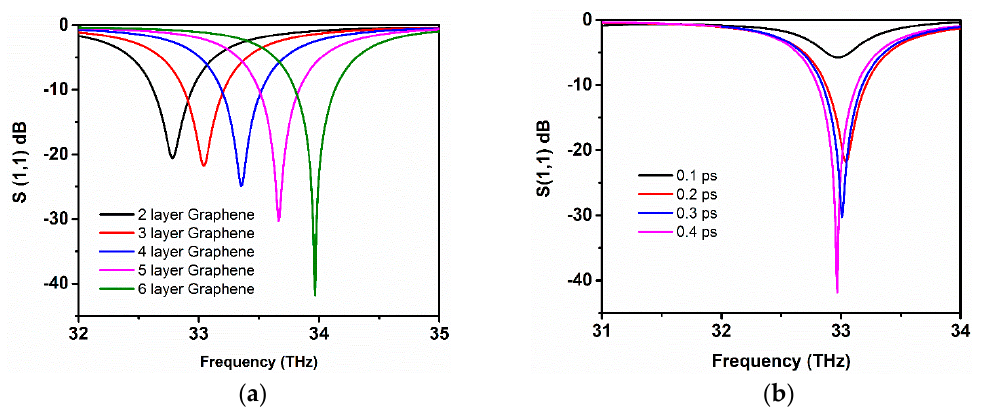
Figure 7. ( a ) Resonant frequency tuning with increasing graphene layers in the stack; and, ( b ) E ff ect of the relaxation time on the reflection coe ffi